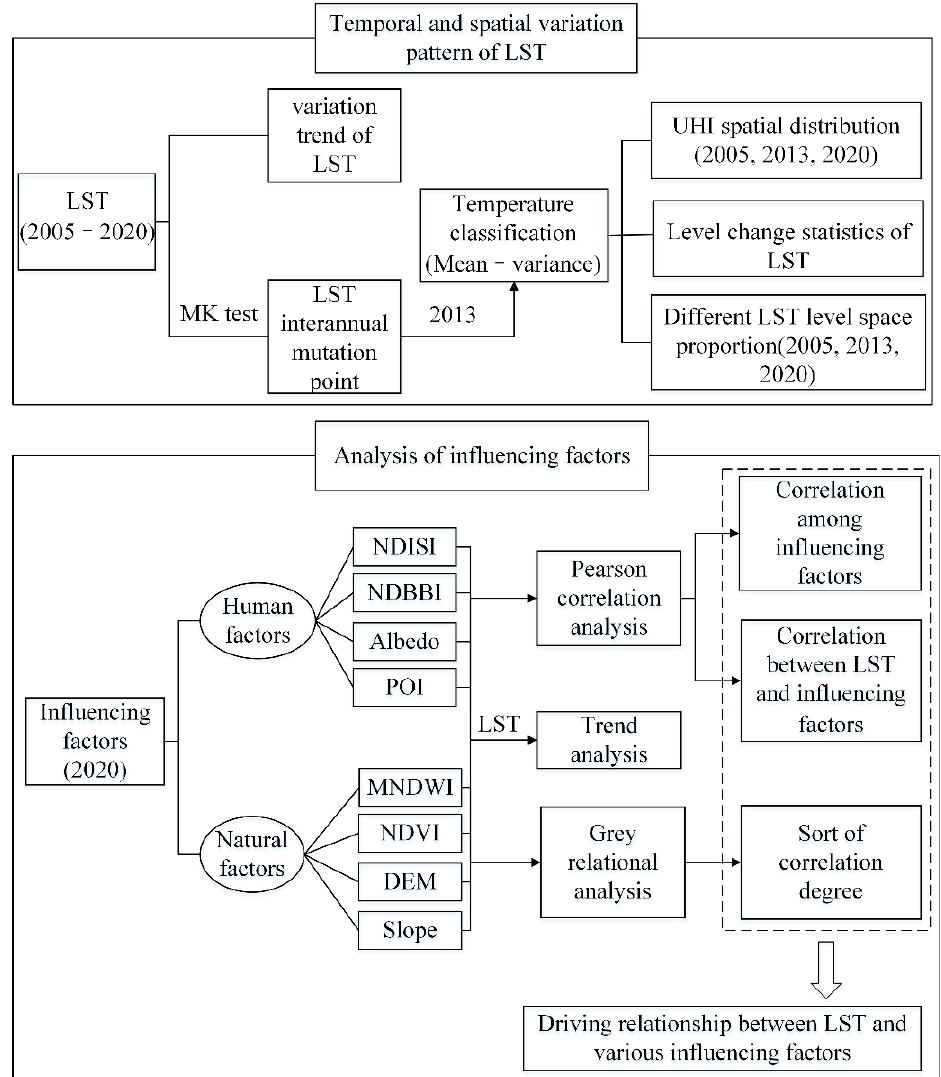
Figure 2. Framework of this